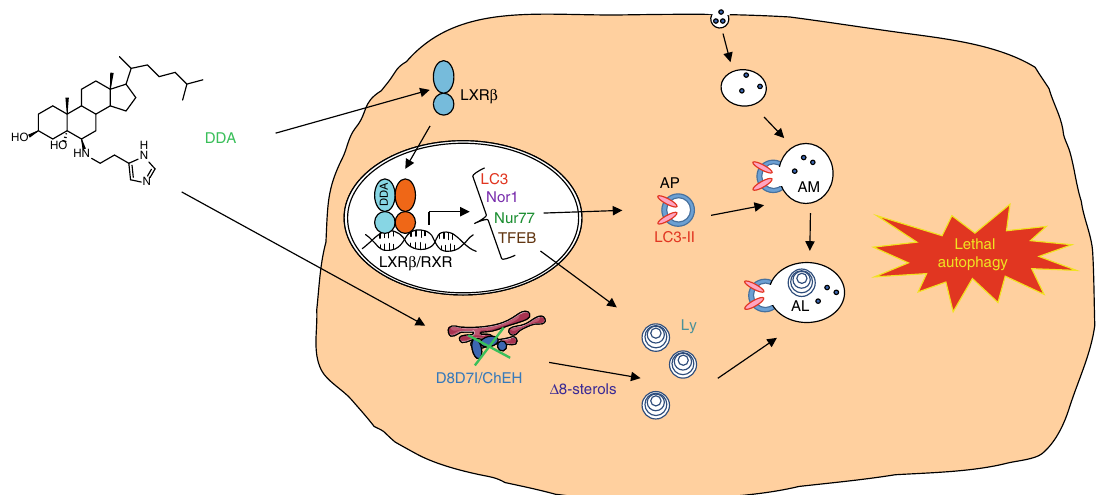
Fig. 9 Molecular mechanisms through which DDA induced lethal autophagy in cancer cells. D8D7I, 3 β -hydroxysterol- Δ 8,7-isomerase; ChEH, cholesterol- 5,6-epoxide hydrolase; Δ 8-sterols, zymostenol and 8-DHC; Ly, lysosome; AM, amphisome; AL, autolysosome; AP,